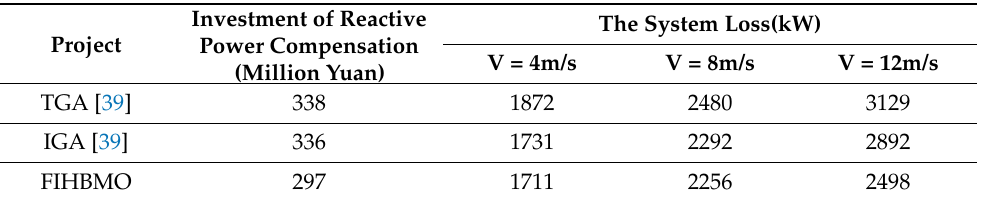
Figure 7. Model of wind farm with 42 nodes. Table 5. Compared results of reactive power optimization in wind farms. Reproduced from [39], Springer: